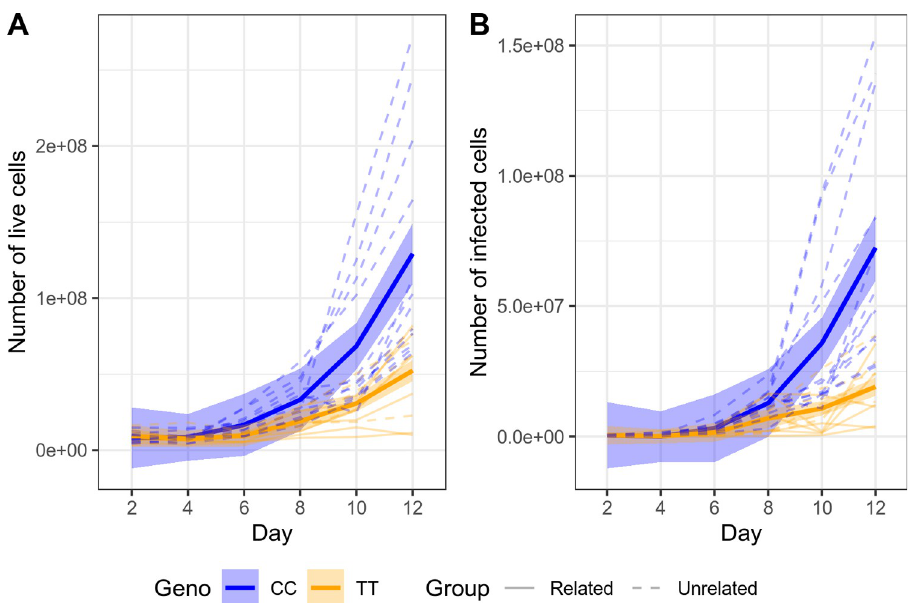
Fig 5. Cell expansion and infectivity levels in cultured cells infected with T . parva . (A) Animals possessing a C/C genotype at the FAF1B SNV exhibit higher live counts throughout the course of infection compared to T/T animals. The association between live cell count and genotype when fitting day as an interaction term and accounting for relatedness is significant (F-test p = 1.42 x 10 − 07 ). (B) In addition, animals possessing a C/C genotype exhibit a higher proportion of infected (PIM+) live cells, which is also significant (F-test p = 7.56 x 10 − 09 ). Thin dashed lines indicated unrelated animals, solid, thin lines indicate animals from the ECF-tolerant pedigree. The blue and orange ribbons and thick blue and orange lines indicate the 95% confidence interval around the mean for C/C and T/T genotypes, respectively. The data underlying these figures is provided in the supporting information (S7